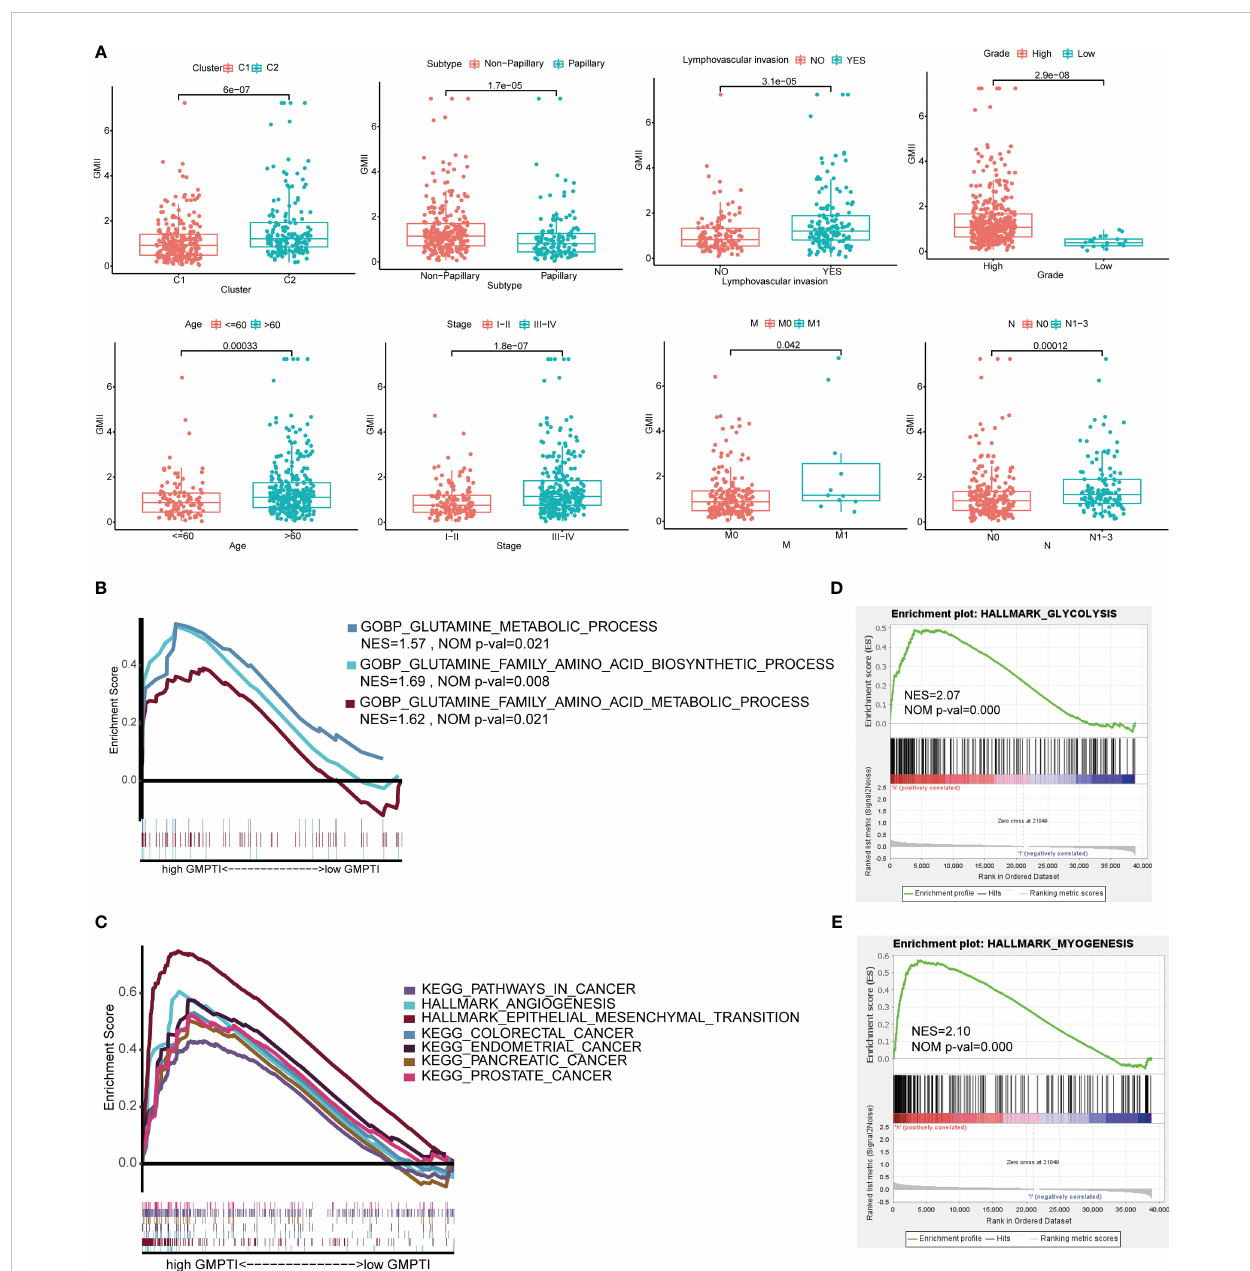
FIGURE 4 Correlation between GMII and clinical traits and gene set enrichment analysis in high-GMII group. (A) Differences in GMII between different clinical feature groups. (B) Pathways related to glutamine metabolism are abundant in the high-GMII group. (C) Glycolysis was signi fi cantly enriched in the high-GMII group. (D) Pathways associated with tumor development and progression are abundant in the high-GMII group. (E) Muscle synthesis was signi fi cantly enriched in the high-GMII